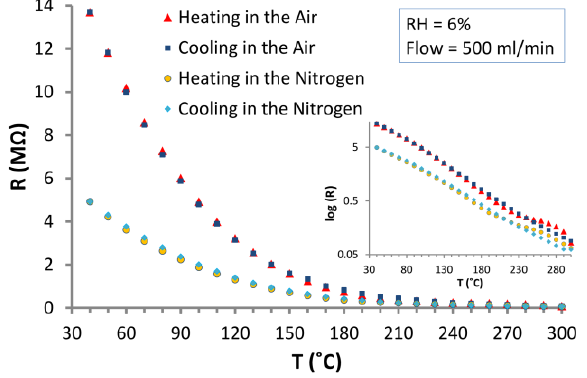
Figure 7. Dependence of the resistance of the structure based on ZnO nanoparticles on temperature in: synthetic air and in nitrogen (gas flow = 500 mL/min., RH = 6%).